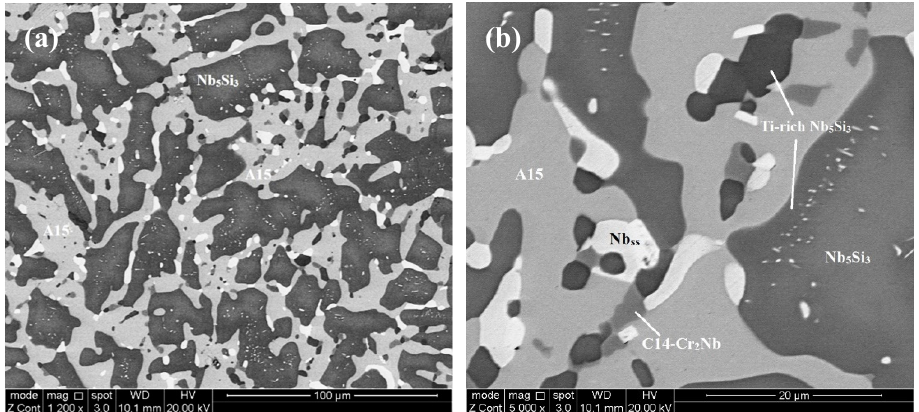
Figure 4. BSE images of the bulk microstructure of the alloy JZ3-HT: ( a ) low and ( b ) higher magnification images showing precipitation of second phase in silicide grains.